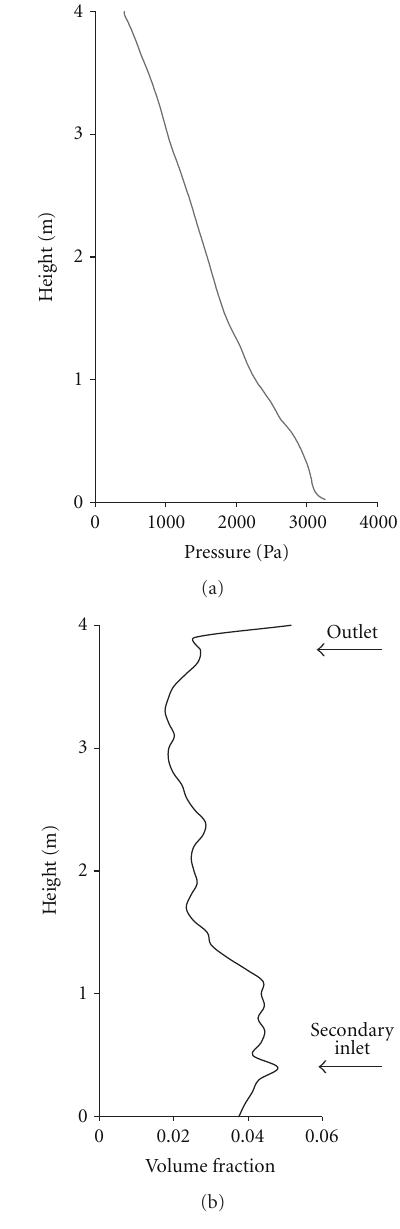
Figure 6: Time-averaged CFD axial profiles for (a) pressure at the center line and (b) solid phase volume fraction calculated as an area average at several cross section planes along the height of the